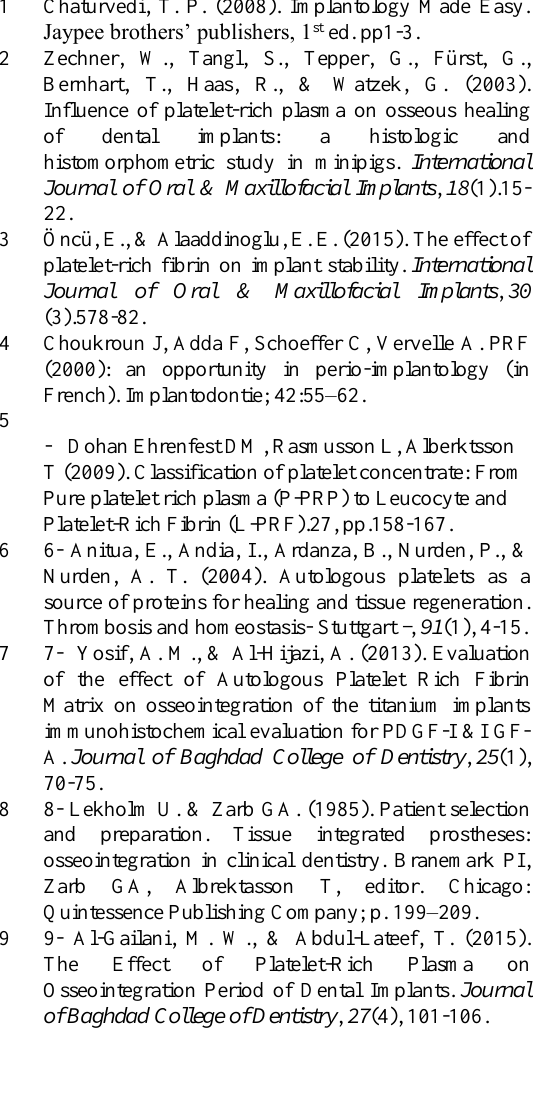
II: evaluation of the vibration shocks of 4 models of table centrifuges for L-PRF. Poseido ;